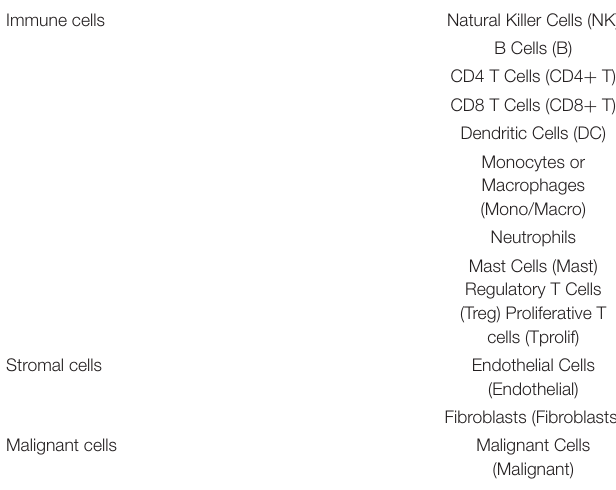
TABLE 3 | The tumor microenvironment including immune cells/inflammatory cells, stromal cells, and malignant cells. Immune